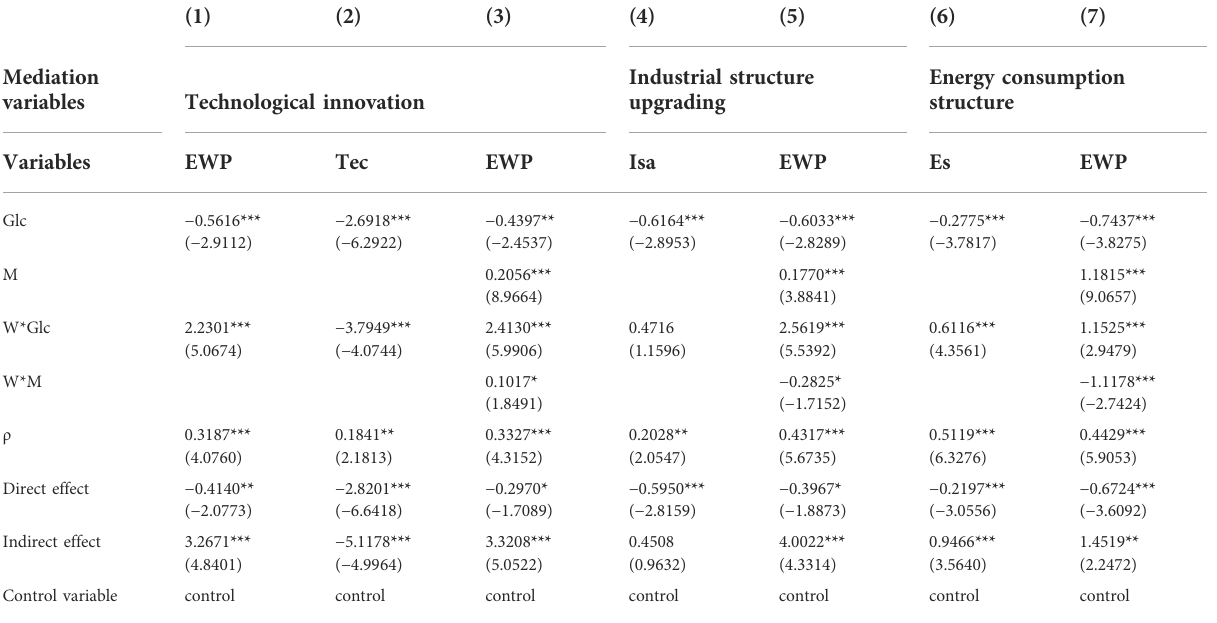
TABLE 8 The results of robustness test (replacement of weight matrix).